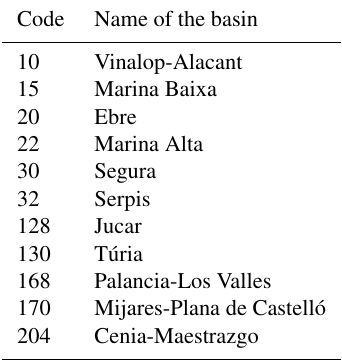
Table A2. Corresponding names of the codes of the basins of the Valencian Community